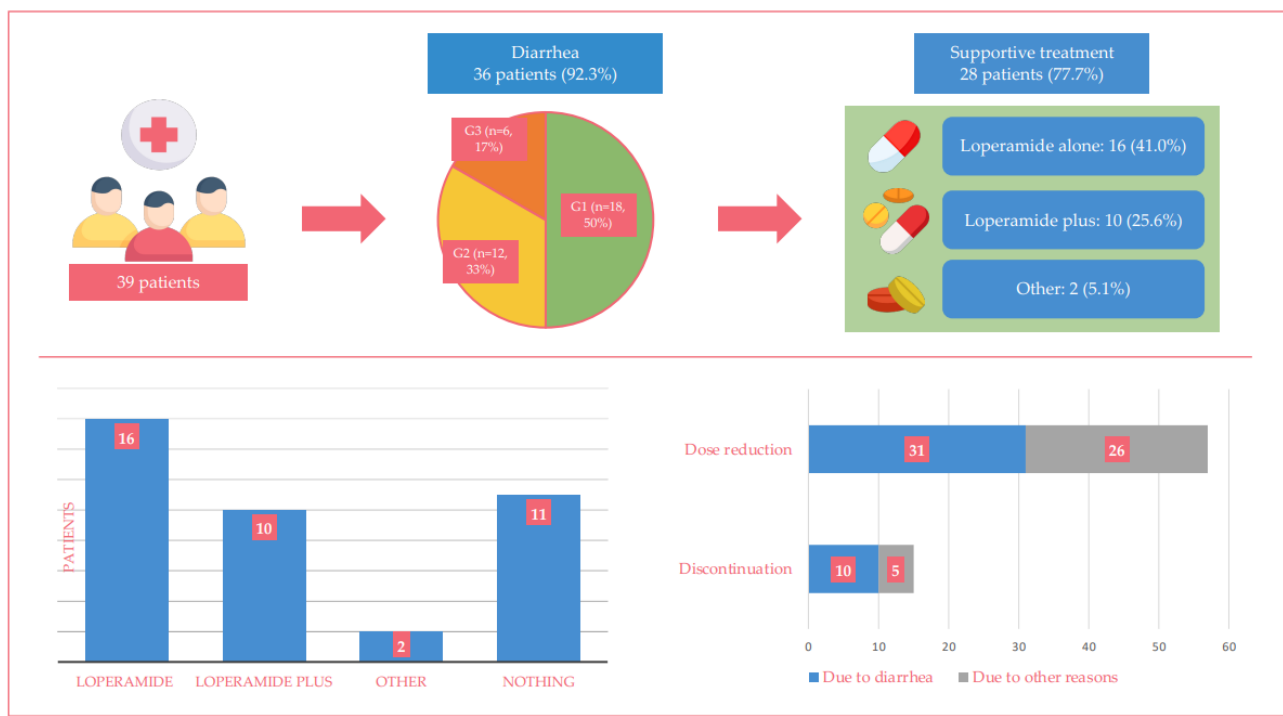
Figure 3. The figure shows the incidence, severity of diarrhea, and type of supportive therapy among the patients enrolled in the study. The histogram at the bottom left shows the type of supportive treatment administered, while the bar chart at the bottom right shows the percentage of dose reduction and treatment discontinuation in the 36 patients who had diarrhea of any grade.